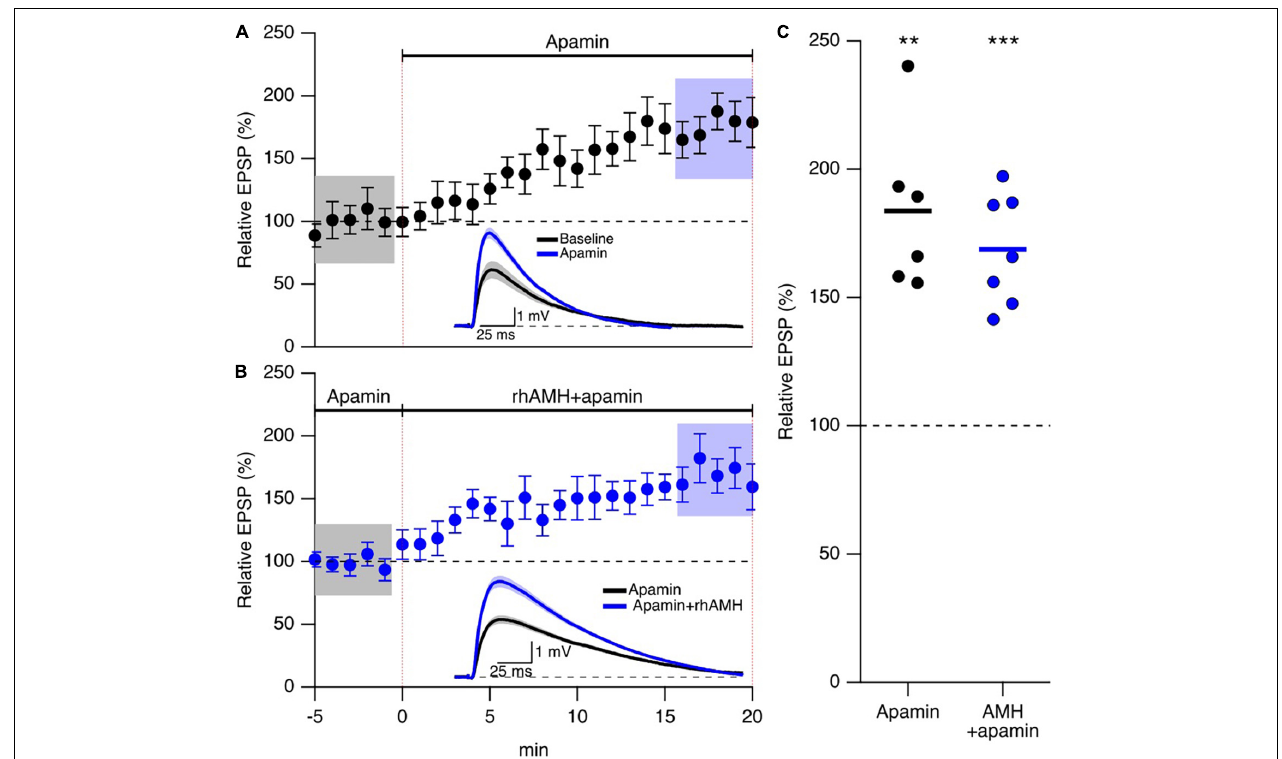
FIGURE 5 | Anti-Müllerian hormone boosting of synaptic responses does not require SK2 channels. (A) Summary time course plots of normalized evoked EPSP amplitudes in control aCSF and bath application of 100 nm apamin at 0–20 min. Data are binned into 1 min intervals, mean ± SEM. The voltage traces used for averaging were taken at time points highlighted with gray and blue shadings. Representative voltage traces (average of 15 EPSPs) were acquired in the absence (black) and presence (blue) of rhAMH for individual neurons. (B) Summary time course plots of normalized evoked EPSP amplitudes in the presence of 100 nM apamin and bath application of 0.4 nM rhAMH at 0–20 min. Apamin did not occlude the increase in EPSP by rhAMH. Data are binned into 1 min intervals, mean ± SEM. The voltage traces used for averaging were taken at time points highlighted with gray and blue shadings. Representative voltage traces (average of 15 EPSPs) were acquired in the absence (black) and presence (blue) of rhAMH for individual neurons. (C) Summary scatterplot of relative increase in EPSP amplitude by apamin (black symbols) and by rhAMH in apamin (blue symbols), ** p < 0.01, *** p <